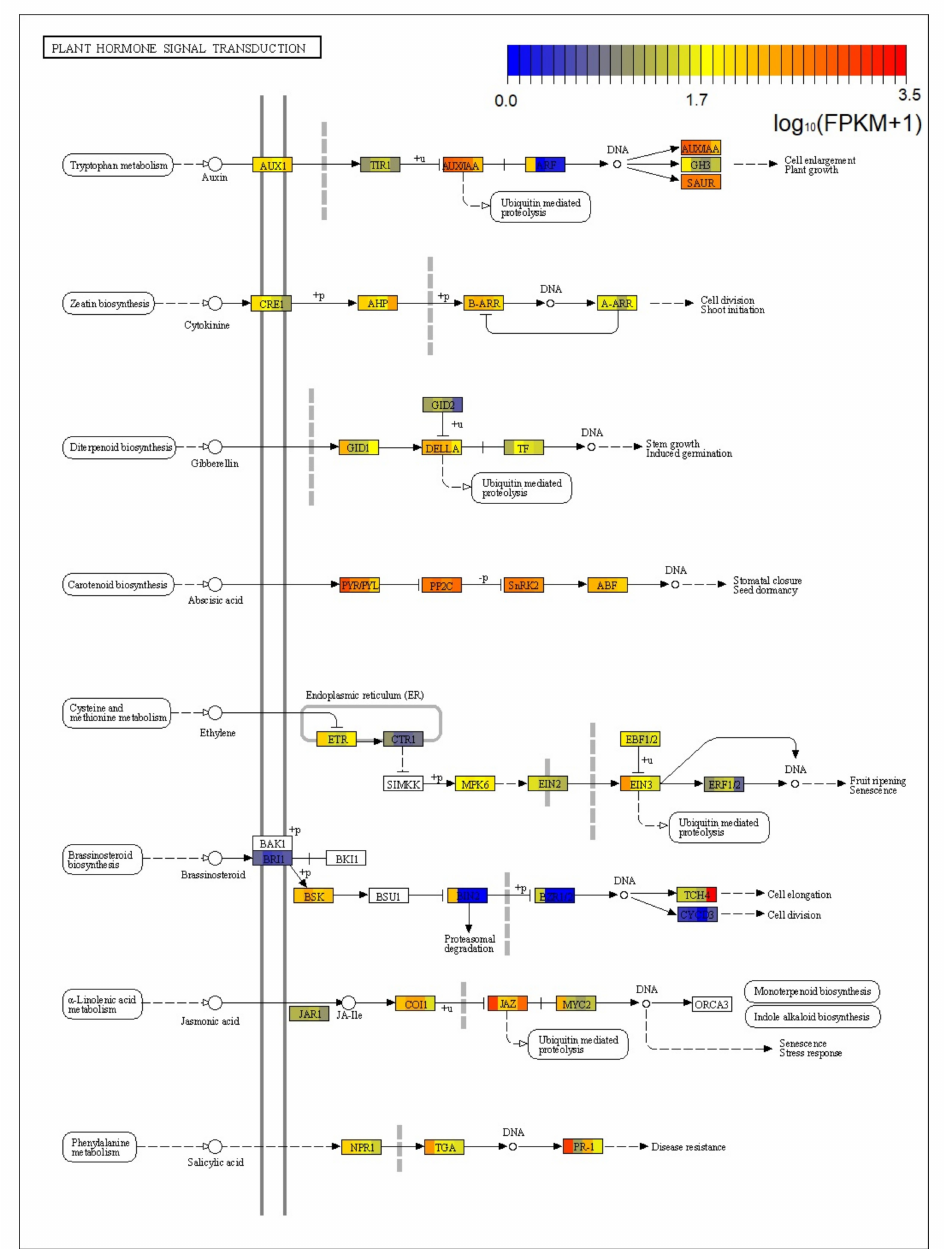
Figure 9. Metabolic pathway of plant hormone signal transduction in C. oliveri. The color boxes represent substances assigned at least one unigene in C. oliveri ; the boxes are divided into four colors, representing the genes expression in the root, stem, leaf, and male cone in